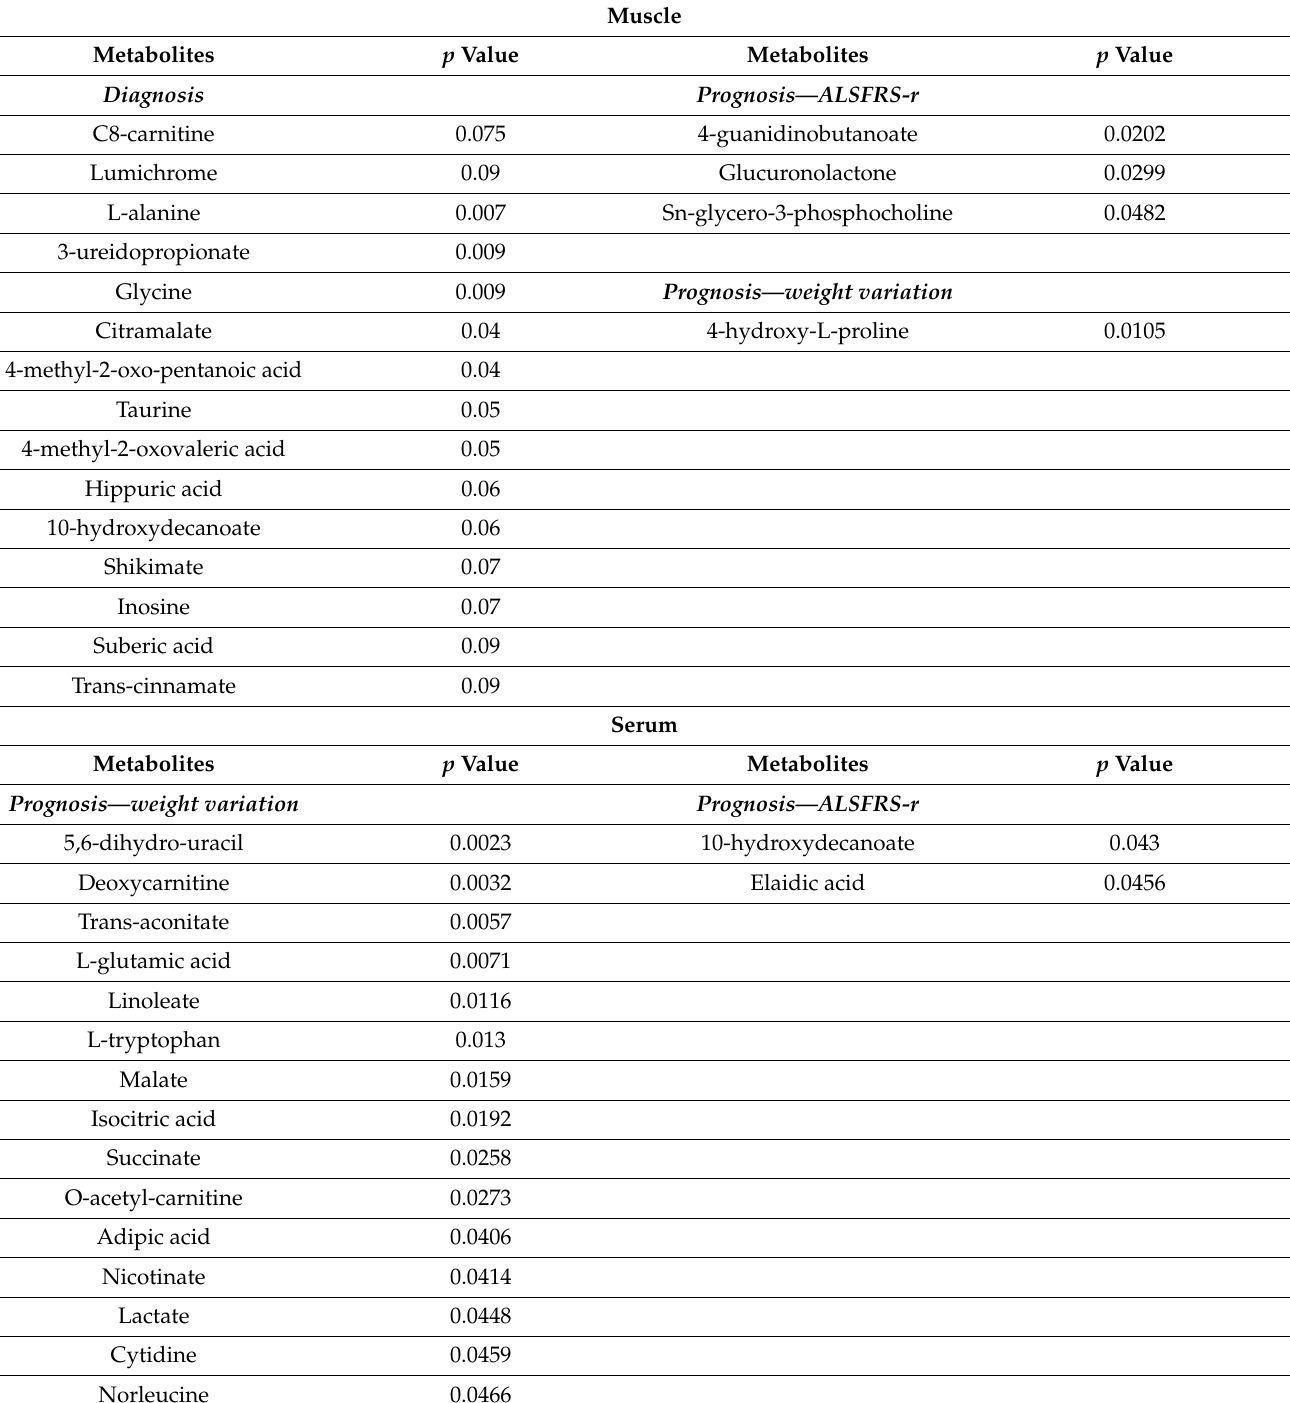
Table 2. Discriminant metabolites associated with clinical parameters of diagnosis or prognosis in serum and